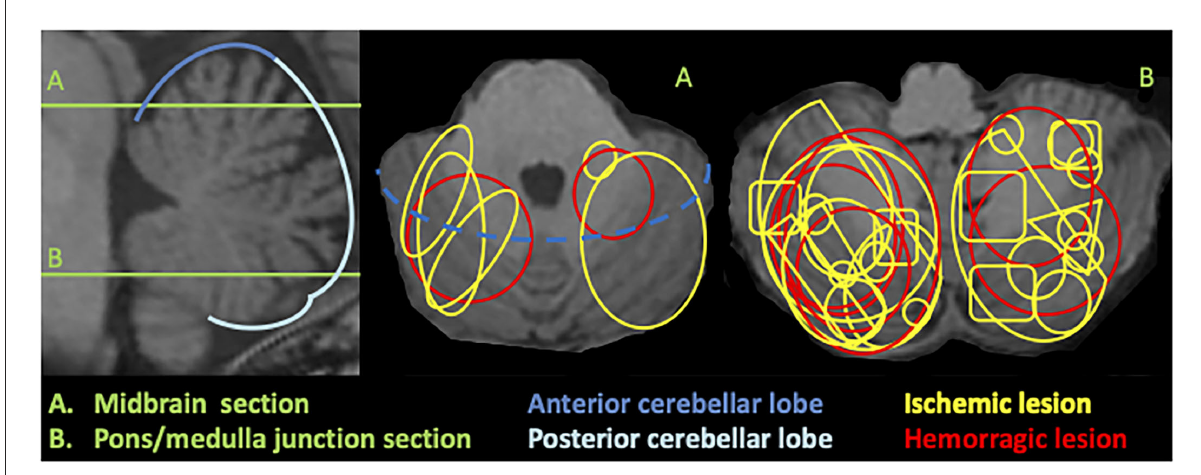
FIGURE1 Schematic illustration of cerebellar lesions superimposed on 3DT1 MRI. Sagittal section (left) shows the level of the axial slices (middle and right): (A) corresponds to a midbrain level and (B) to a pons/medulla junction